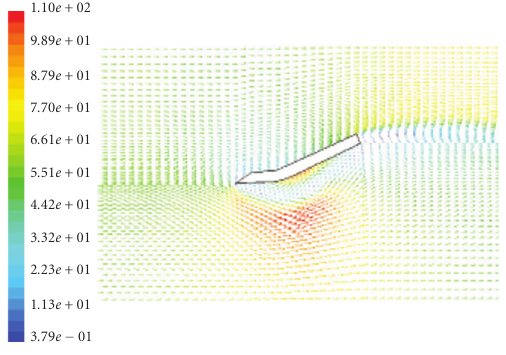
Figure 16: Velocity vectors at the blade section F (m/s, r = 0 .